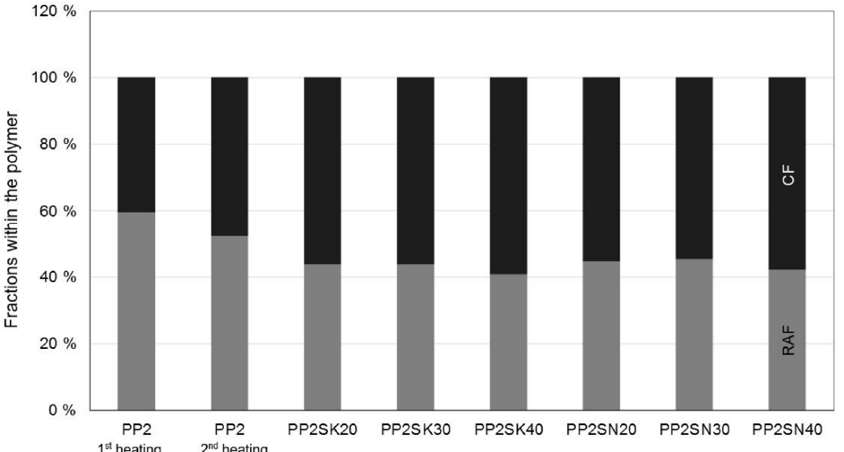
Figure 9. Different properties within the PP. SK is used for the larger particles, whereas SN describes the smaller particles (in %).